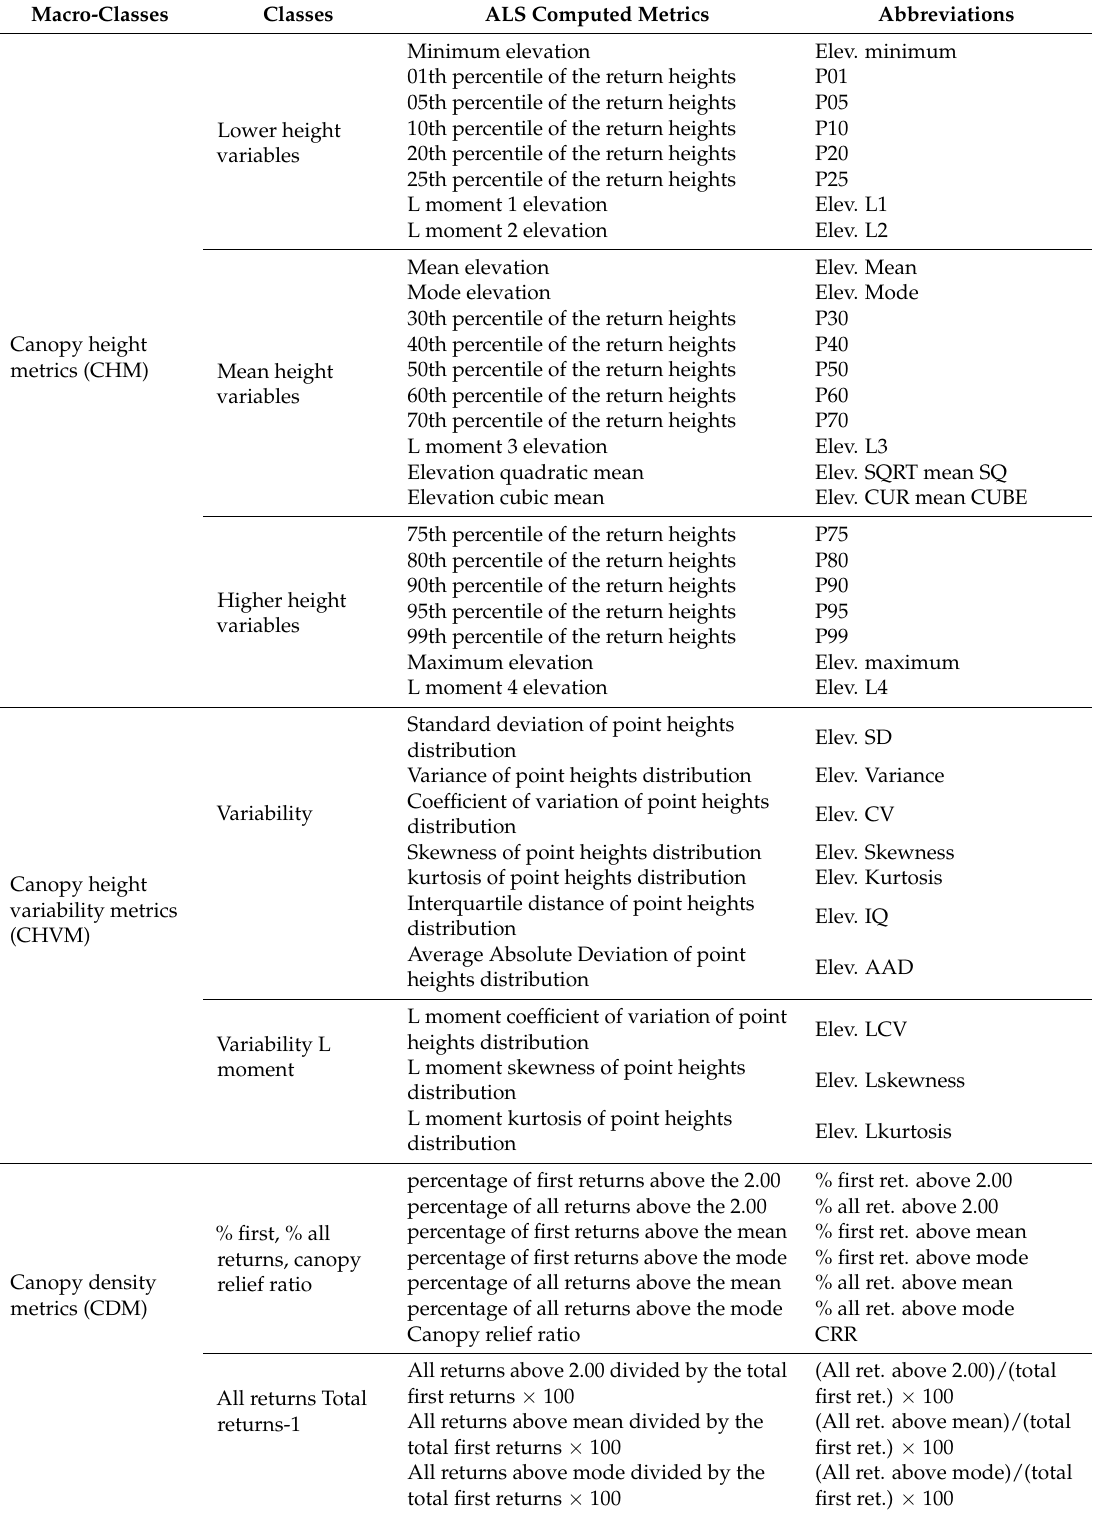
Table A1. Summary of the airborne laser scanning (ALS) computed metrics including the abbreviations, classes, and macro-classes